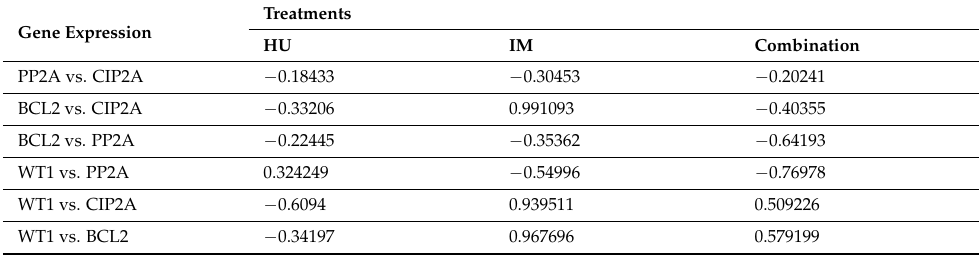
Table 2. Correlation between the studied genes under different treatments for CML